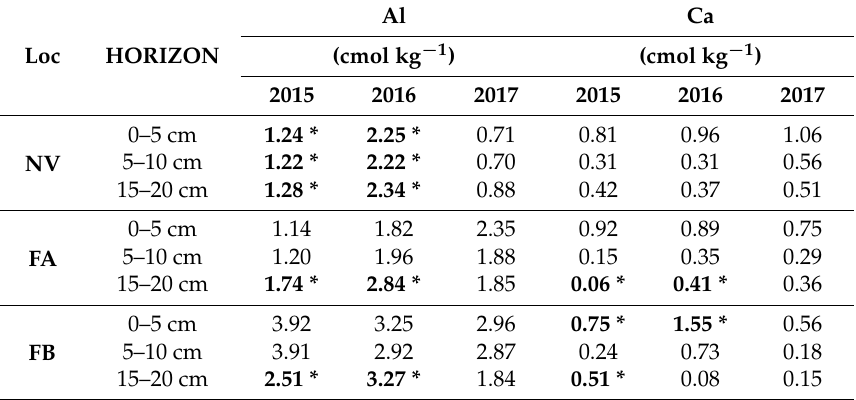
Table 6. Cation exchange analysis before (2015) and after (2016 and 2017) harvesting.